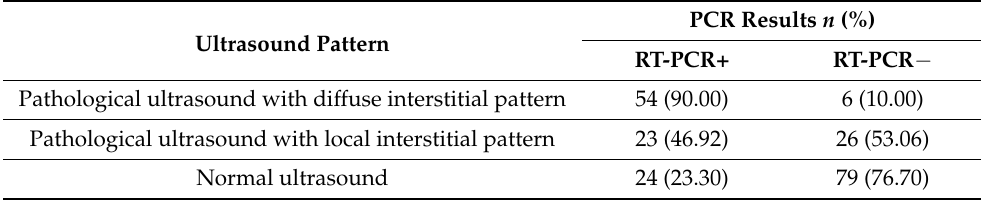
Table 2. Findings from the lung ultrasound and PCR test.